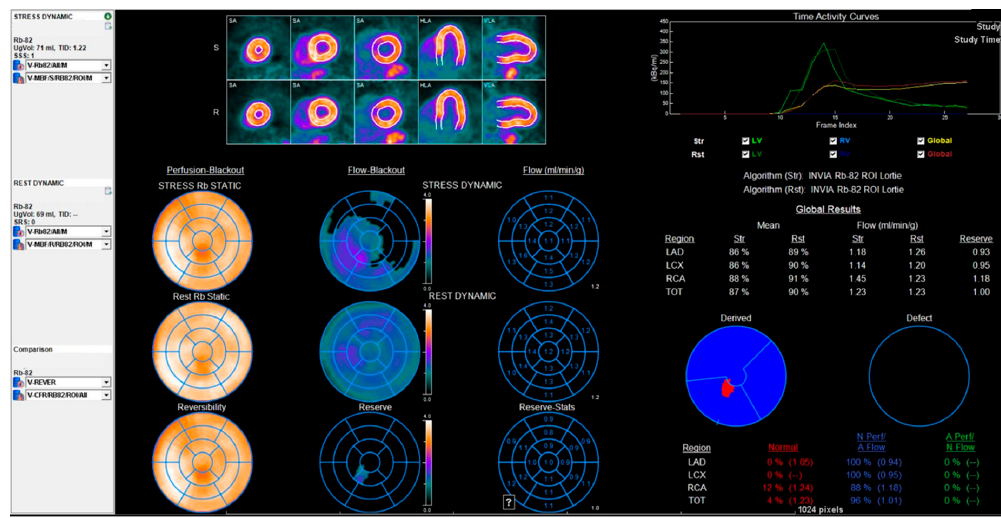
Figure 3. Rubidium-82 regadenoson stress-rest PET (positron emission tomography) in a 64-year-old man with persistent, recurring angina and only mild epicardial CAD (coronary artery disease) on invasive angiography done at an outside hospital. There is abnormal global myocardial perfusion reserve (MPR) <2 consistent with CMD (coronary microvascular dysfunction). He was prescribed Ranolazine and high intensity statin therapy, and had dramatic improvement in 1 months’ time. LAD = Left anterior descending coronary artery, RCA = Right coronary artery, LCX = Left circumflex artery, TOT = Total, LV = Left ventricle, RV = Right ventricle.